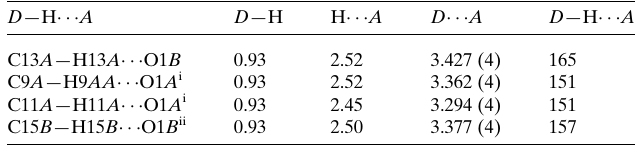
Table 1 Hydrogen-bond geometry (A˚ , (cid:3) ).